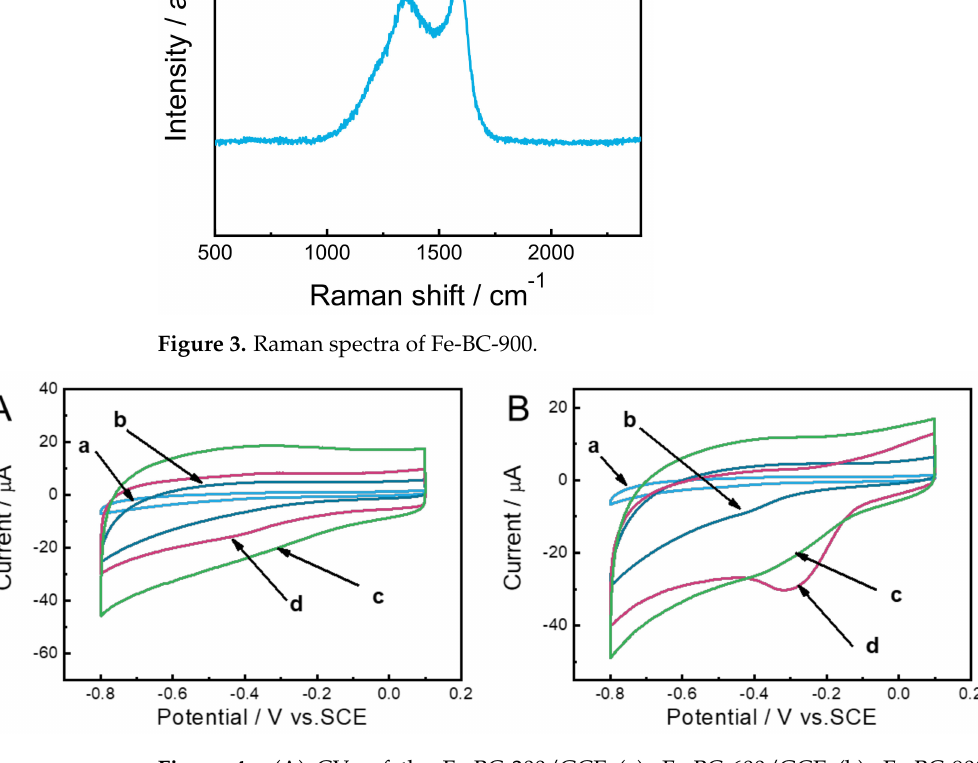
Figure 4. ( A ) CVs of the Fe-BC-300/GCE (a), Fe-BC-600/GCE (b), Fe-BC-900/GCE (c), and Fe-BC-900/GCE (d) in N 2 -saturated 0.1 M KOH; ( B ) CVs of the Fe-BC-300/GCE (a), Fe-BC-600/GCE (b), BC-900/GCE (c), and Fe-BC-900/GCE (d) in N 2 -saturated 0.1 mM H 2 O 2 0.1 M